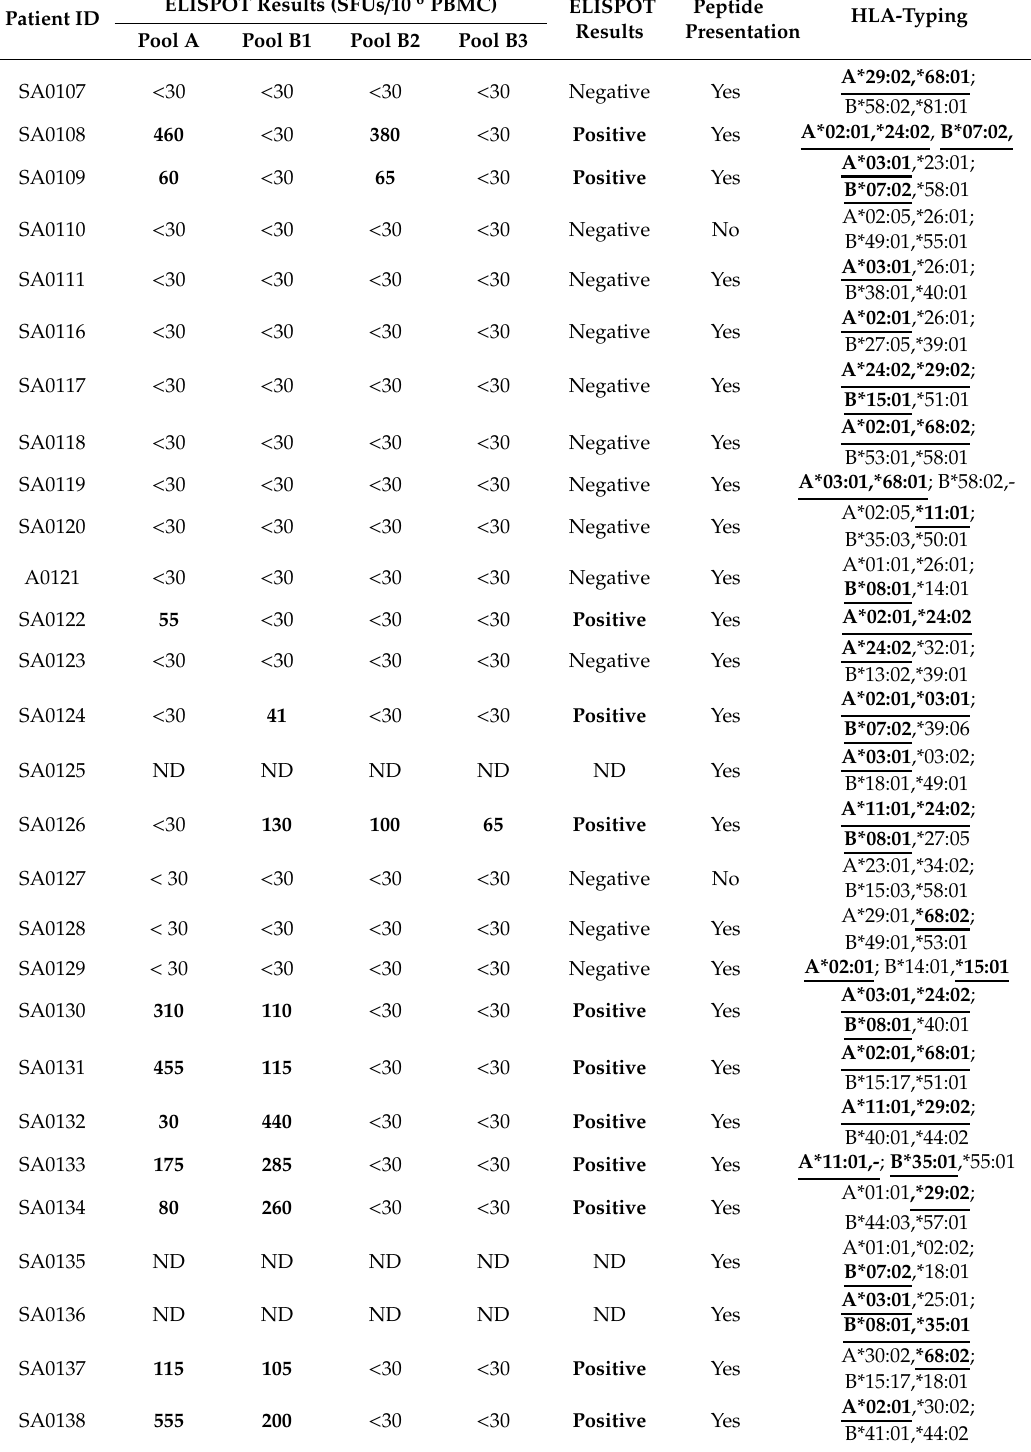
Table 3. ELISPOT results according to HLA alleles expressed by the patients. The table shows quantitative data of ELISPOT assay in SFUs / 10 6 PBMC according to the peptide pool used: A, pool of 15 peptides; B1, B2 and B3 were subpools, as described in Table 1. The positivity threshold was set at 30 SFUs / 10 6 PBMC. Underlined and bolded alleles are those showing high affinity for one or several peptides of pool A. ND: not determined (negative control MOG showed more than 30 SFUs / 10 6 PBMC). HLA-B typing of patient SA0122 was not